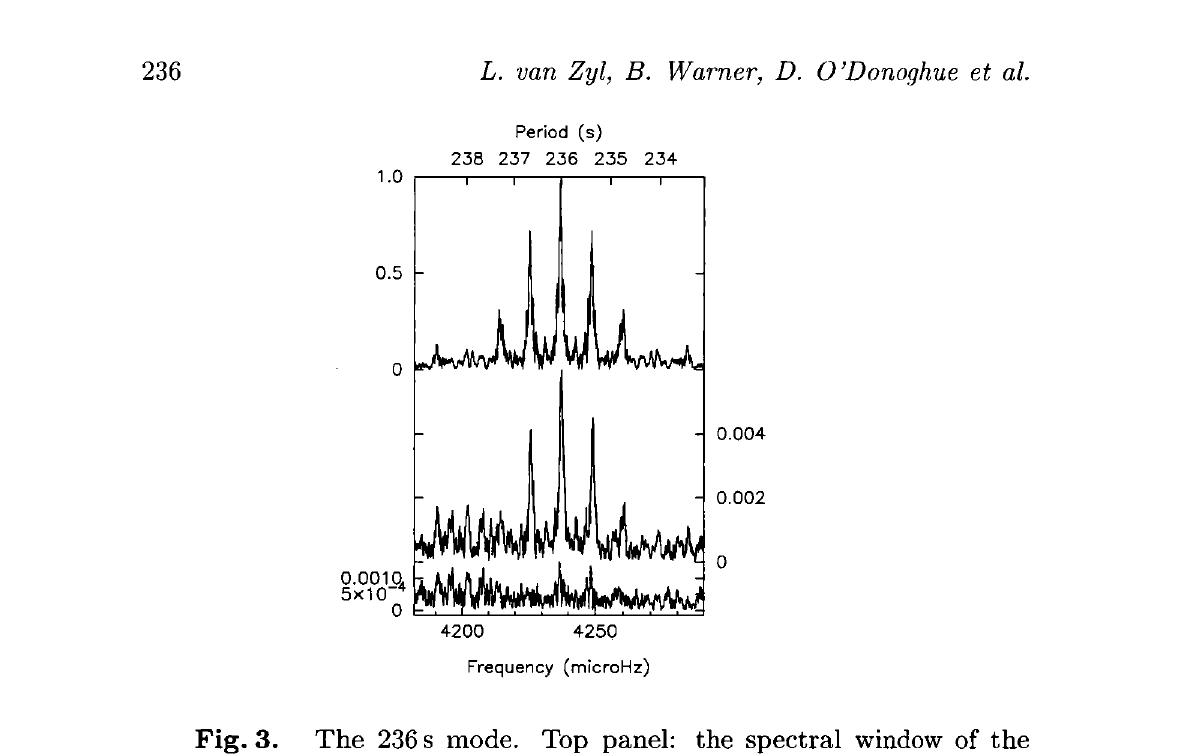
Fig. 3. The 236 s mode. Top panel: the spectral window of the May/Jun98 dataset. Middle panel: the mode at 236 s. Bottom panel: a low-amplitude component revealed after prewhitening with the dominant signal at 236 s. (The "bump" left of centre is probably a linear combination